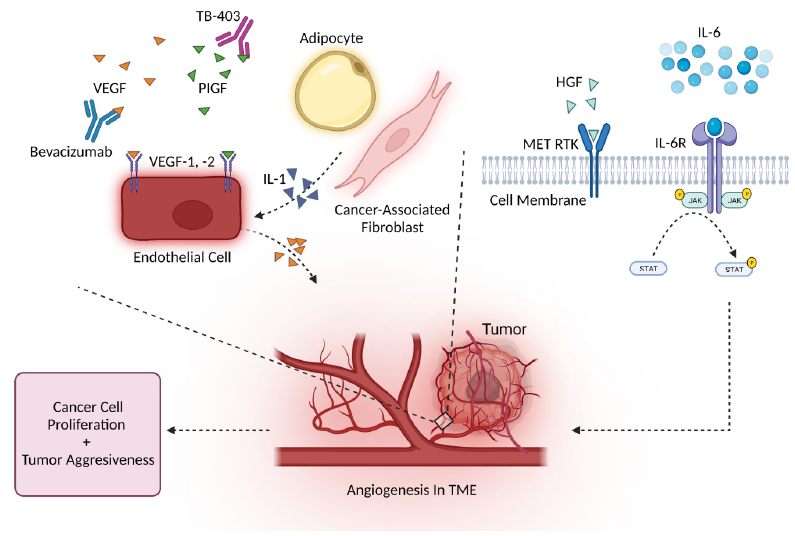
Figure 3. Several cytokines, cell types, and signaling pathways drive angiogenesis. Increased vasculature supports tumor growth and aggressiveness. Bevacizumab may be used to block VEGF, while TB-403 may potentially be used to inhibit PIGF to further prevent angiogenesis in TMEs.